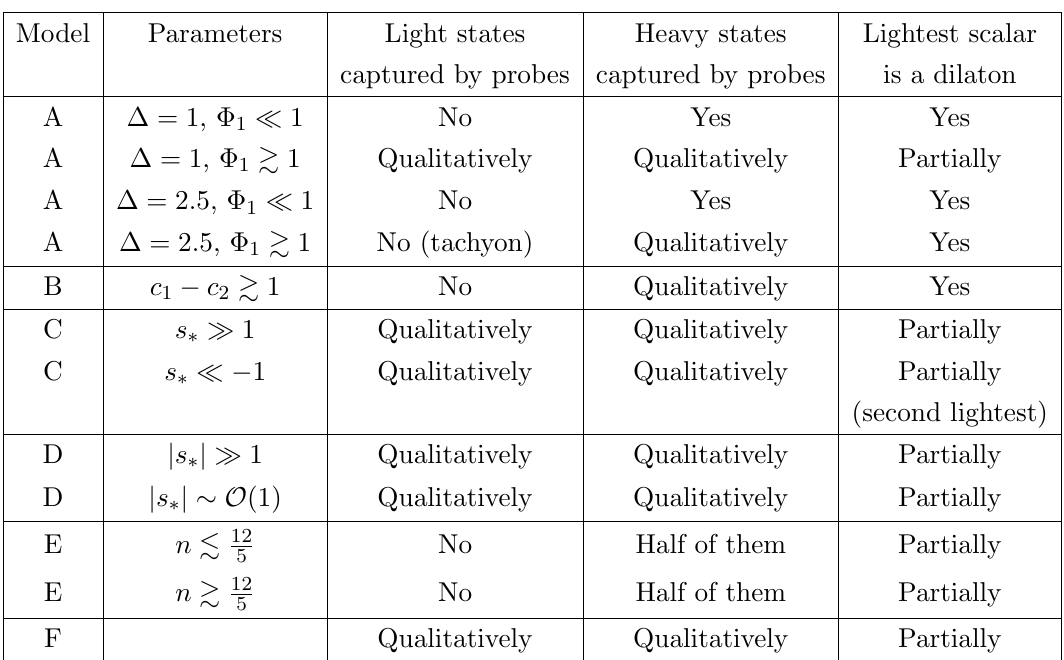
Table 1 . Critical summary of the results of the probe approximation, for all of the six examples discussed in the body of the paper, and (where useful) for di(cid:11)erent values of the parameters. The details can be found in the subsections devoted to each of the individual models. The adverb qual- itatively is used in the table to mean that the spectrum is comparable to the probe approximation, but there are visible numerical discrepancies. Partially refers to cases where the lightest scalar has a sizable overlap with states other than the